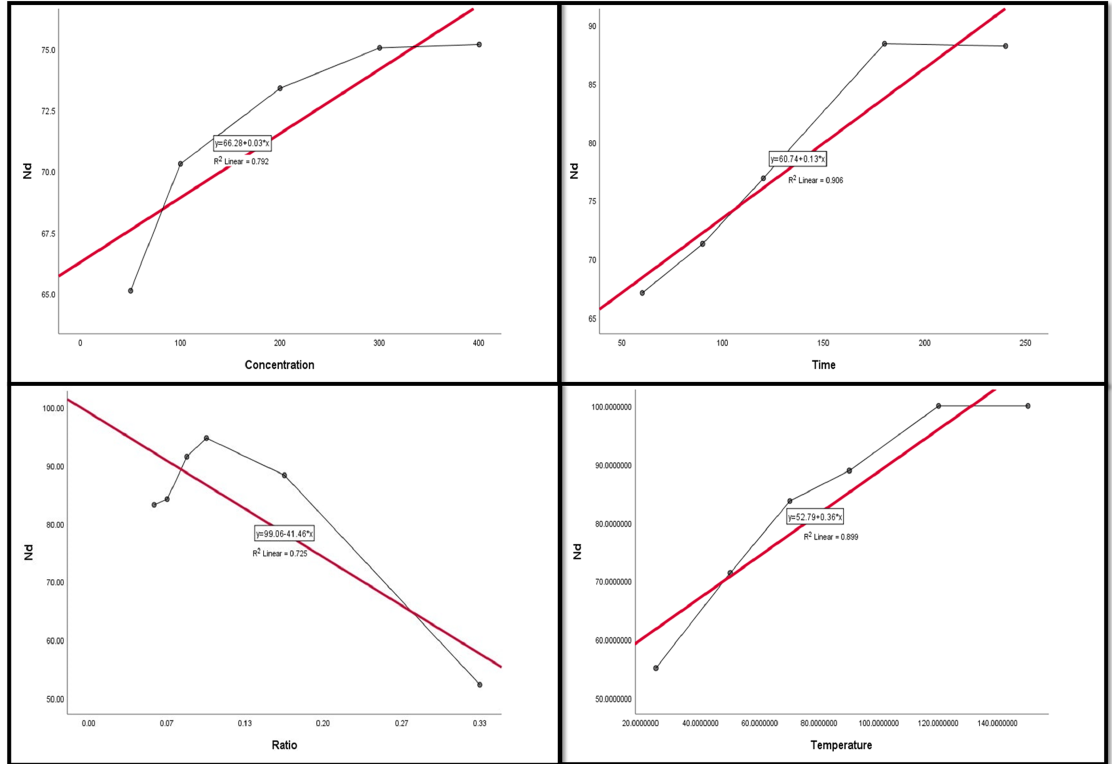
Figure 11. The scatter plot with linear regression fit for Nd leaching efficiency, %, and factors.